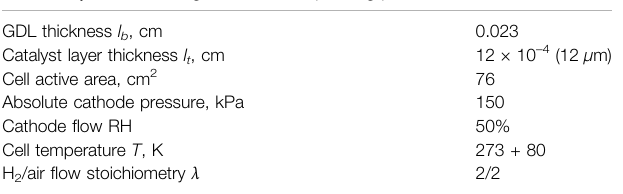
TABLE 3 | PEM fuel cell geometric and operating